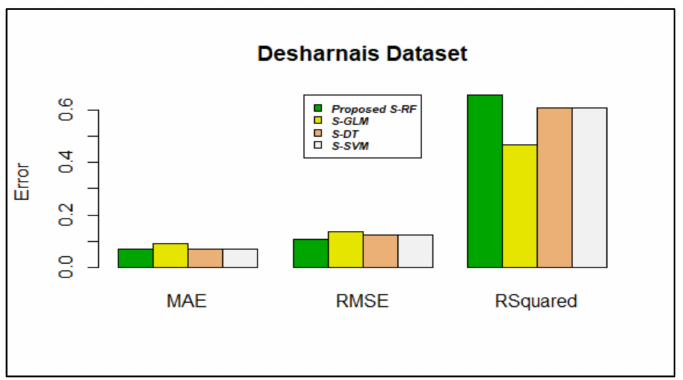
Figure 5. Error rate vs. stacking models in the Desharnais